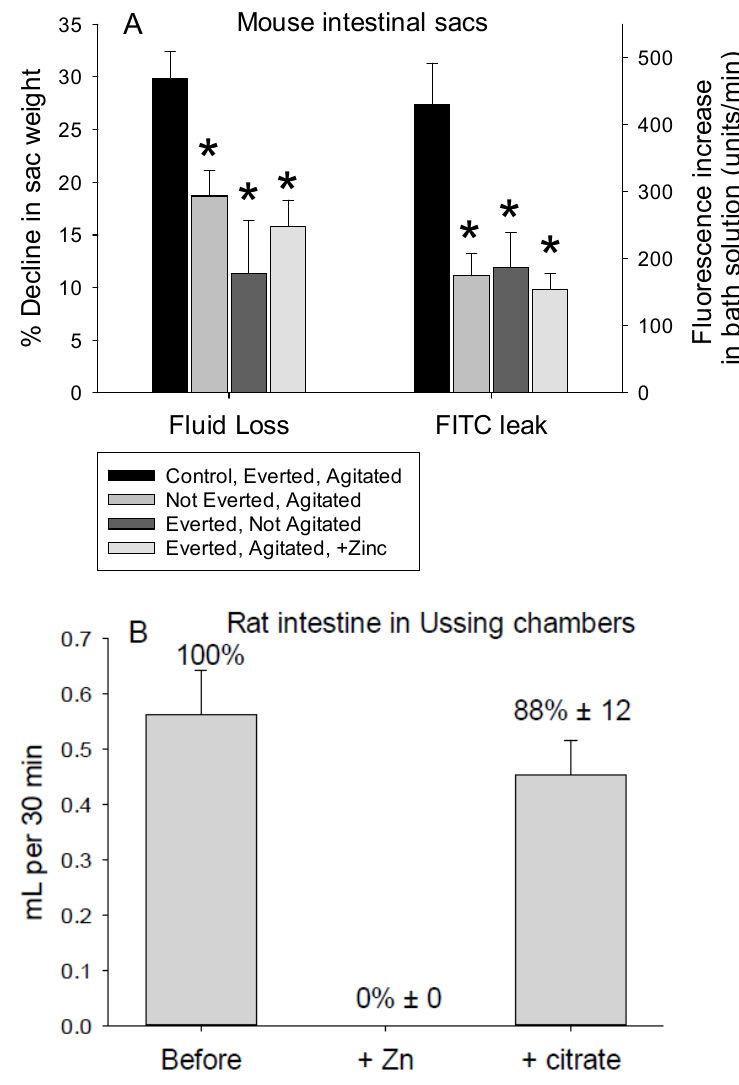
Figure 12. Unidirectional and inhibitable movement of fluid and 4 kD FITC-dextran is measurable with intact tissues. ( A ) Percentage decreases in weight, a measure of fluid loss (left group of bars) and leakage of 4 kD FITC-dextran into the Ringer’s solution incubation solution (right group of bars) from sacs of mouse small intestine as a function of whether the mucosa was internal or external, exposed to vigorous agitation by aeration and stirring, and the addition of zinc sulfate to the incubation solution. Sacs were prepared from 8 mice, with 4 sacs per mouse. ( B ) Fluid flow through intact small intestine from two rats mounted in Ussing chambers and exposed to vigorous aeration was measured before first the addition of zinc sulfate (100 µM) and then citrate (50 µM). Each period of measurements was 5 min ( n = 4 preparations per rat). The asterisks indicate a significant difference was detected for comparisons with control everted